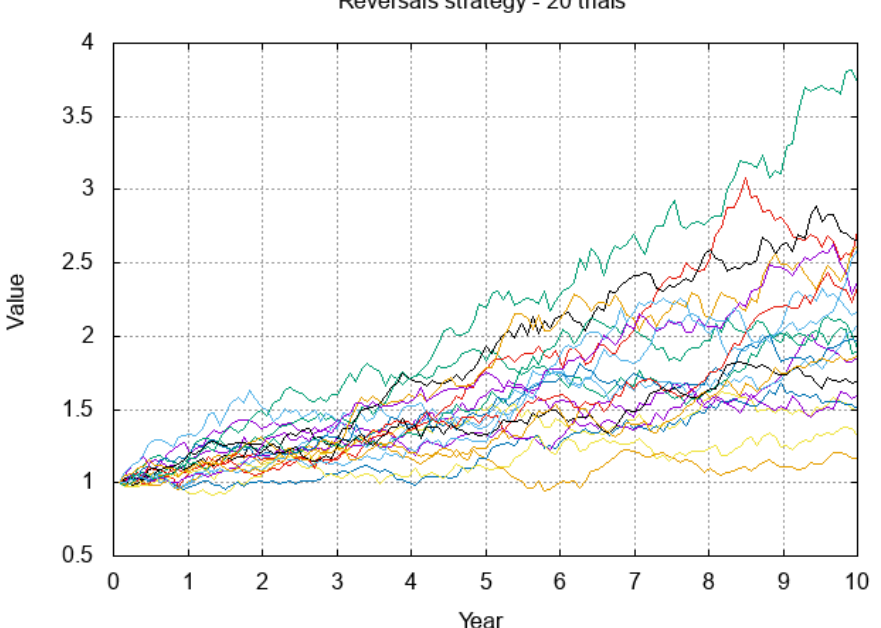
Figure 4. Reversals strategy performance, 20 simulations of 30 stocks, mean reversion 1. With low mean reversion, strategy returns are more modest, and have a higher probability of underperforming the industry. The behavior as a function of the mean reversion is given in Figure 5. Because the reversals strategy holds fewer stocks, it’s return has a higher standard deviation than holding the market. In general, the market return closely follows overall underlying return for C t , which is about 2%. The performance of the reversals strategy improves on this when the mean reversion is large enough. At a mean reversion of 0.75, the average strategy return is 4.1%, double that of the market, albeit with a standard deviation of 2.8%. At a mean reversion of 1.0, the mean return is 6.5%, with a standard deviation of 3.8%. A mean reversion of 2 yields a mean return of 12% with a standard deviation of 3.1%.